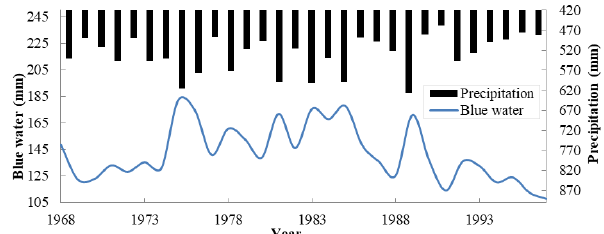
Table 2. The amount of blue and green water within the year. Month